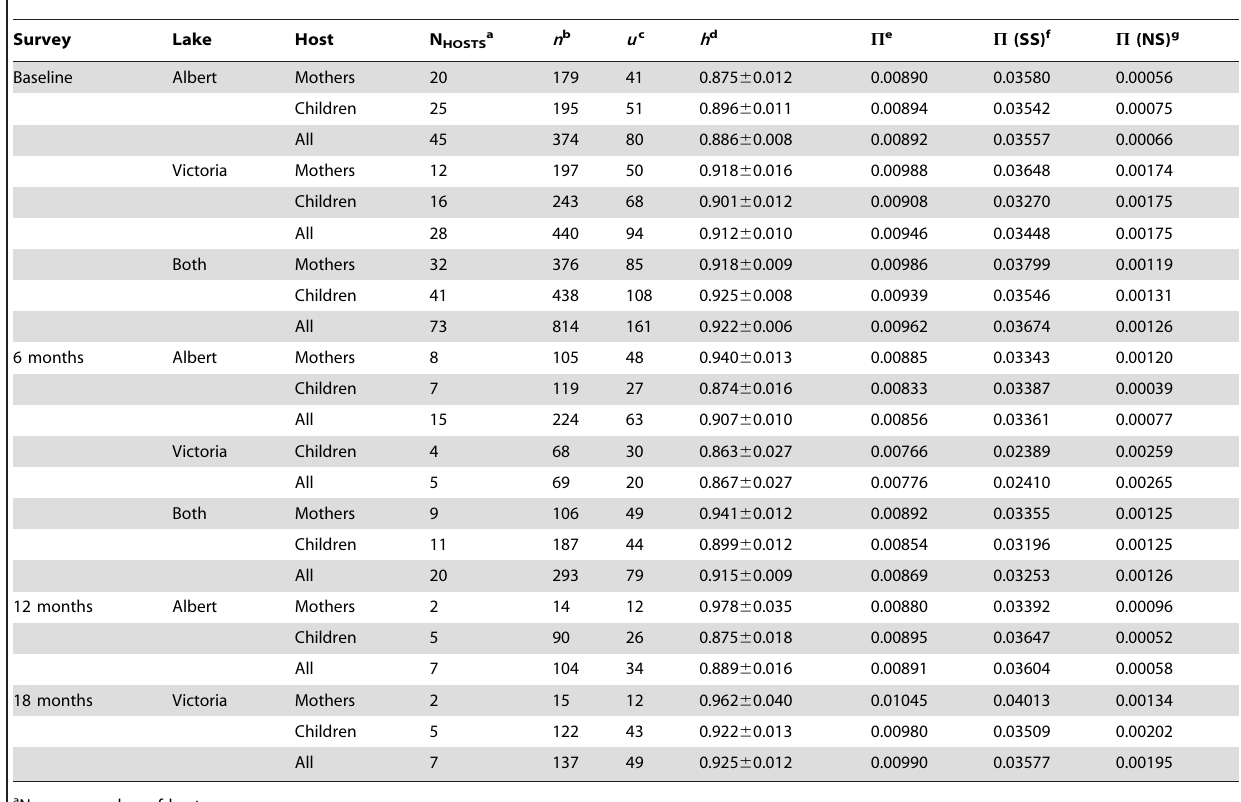
Table 1. Cox 1 diversity stratified by host type, lake system and survey timepoint.